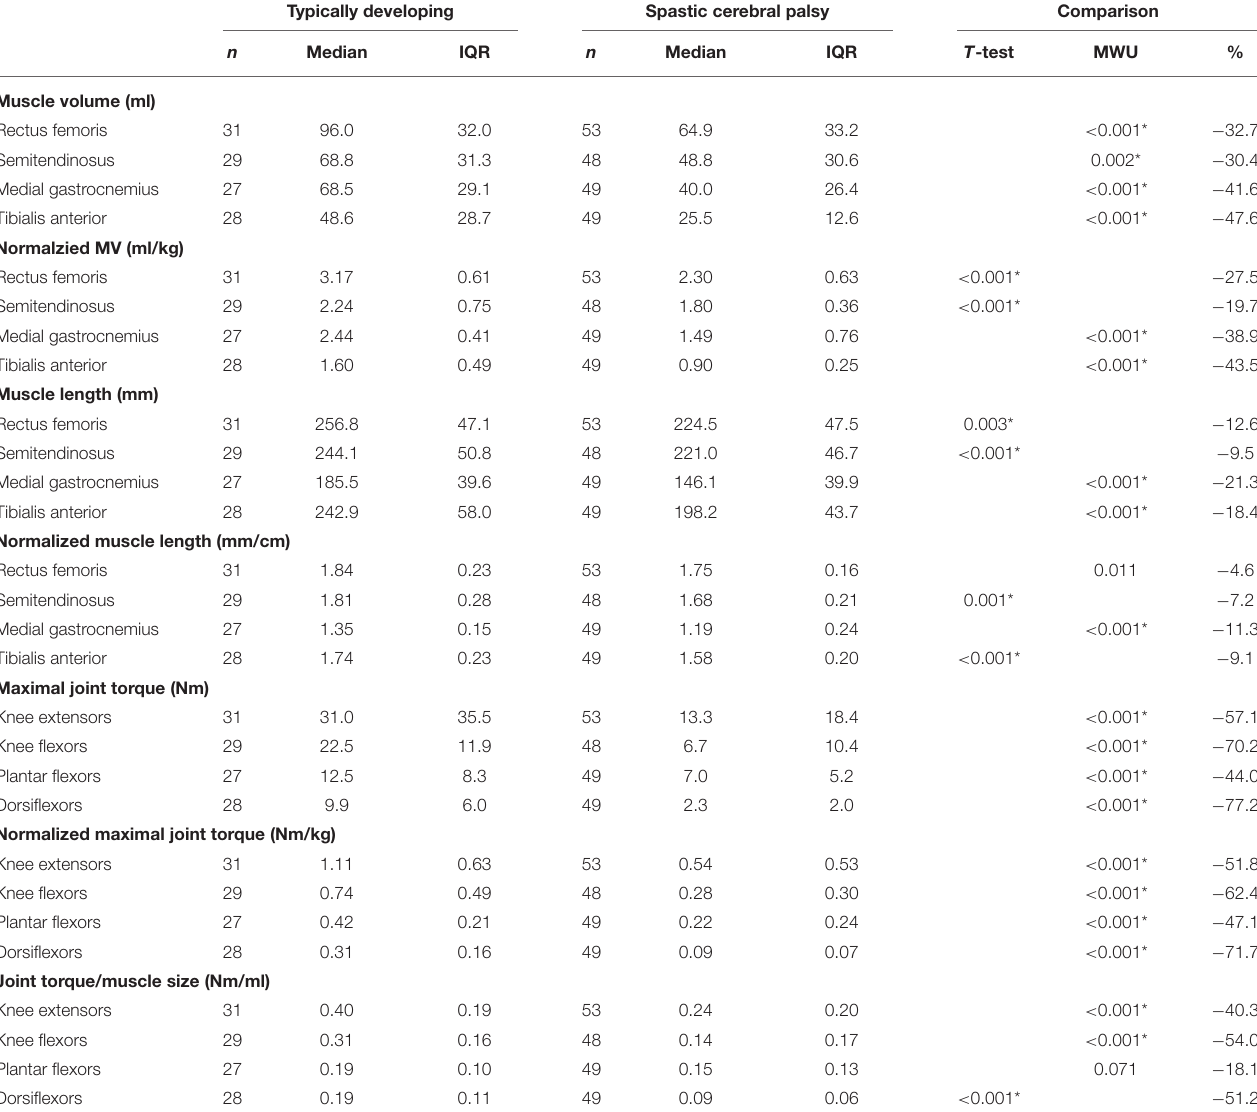
TABLE 2 | Comparisons of muscle morphology and maximal joint torque. Typically developing Spastic cerebral palsy